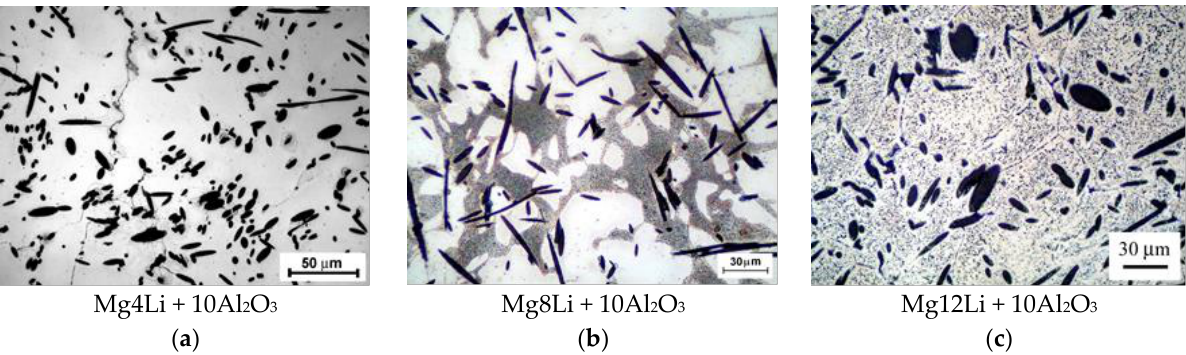
Figure 2. Microstructure of composites: ( a ) Mg4Li + 10Al 2 O 3 ; ( b ) Mg8Li + 10Al 2 O 3 ; ( c ) Mg12Li + 10Al 2 O 3 .